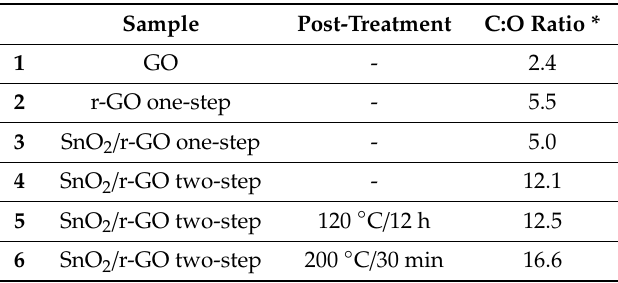
Table 1. C:O atomic ratio calculated from the XPS spectra obtained for the drop-cast films from NMP dispersions. All the samples were dried in an oven at 70 ◦ C for 30 min and some of them were then submitted to the extra post-treatment step, as indicated. GO = commercial graphene oxide; r-GO = reduced graphene oxide, submitted to the solvothermal process for reduction; SnO 2 / r-GO = SnO 2 decorated reduced graphene oxide. * C:O ratio for SnO 2 -containing samples was calculated by subtracting the oxygen atoms linked to Sn.